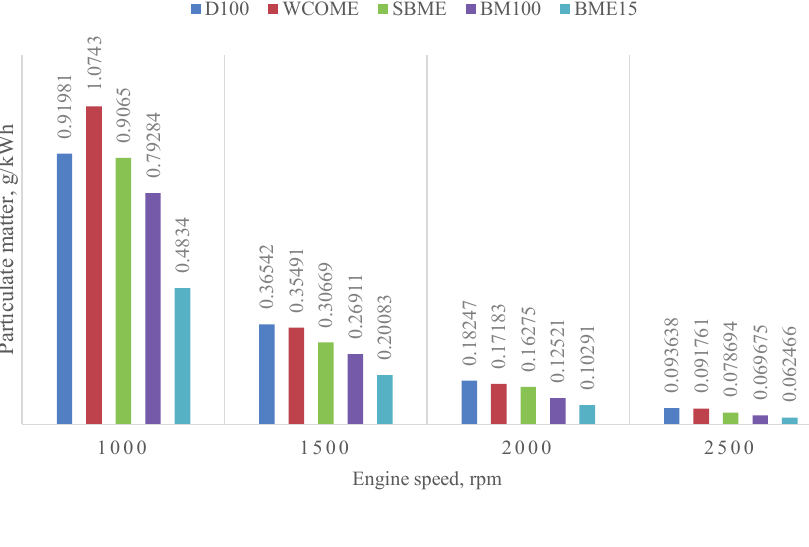
Fig. 7. Variation of particulate matter emissions with engine speed.